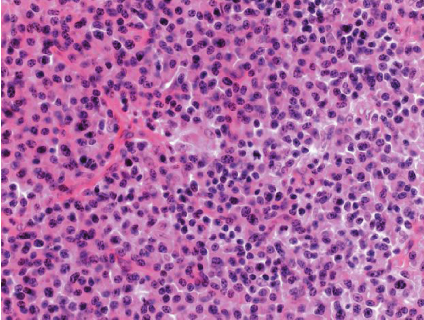
Figure 5: Photomicrograph of surgical specimen. Di ff use infil- trate of neoplastic monoclonal well-di ff erentiated plasma cells is present associated with many deposits of amyloid in the stroma (HES × 200).